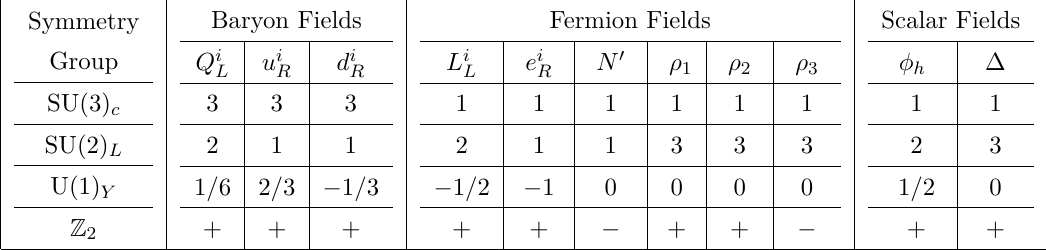
Table 1 . Particle content and their corresponding charges under various symmetry